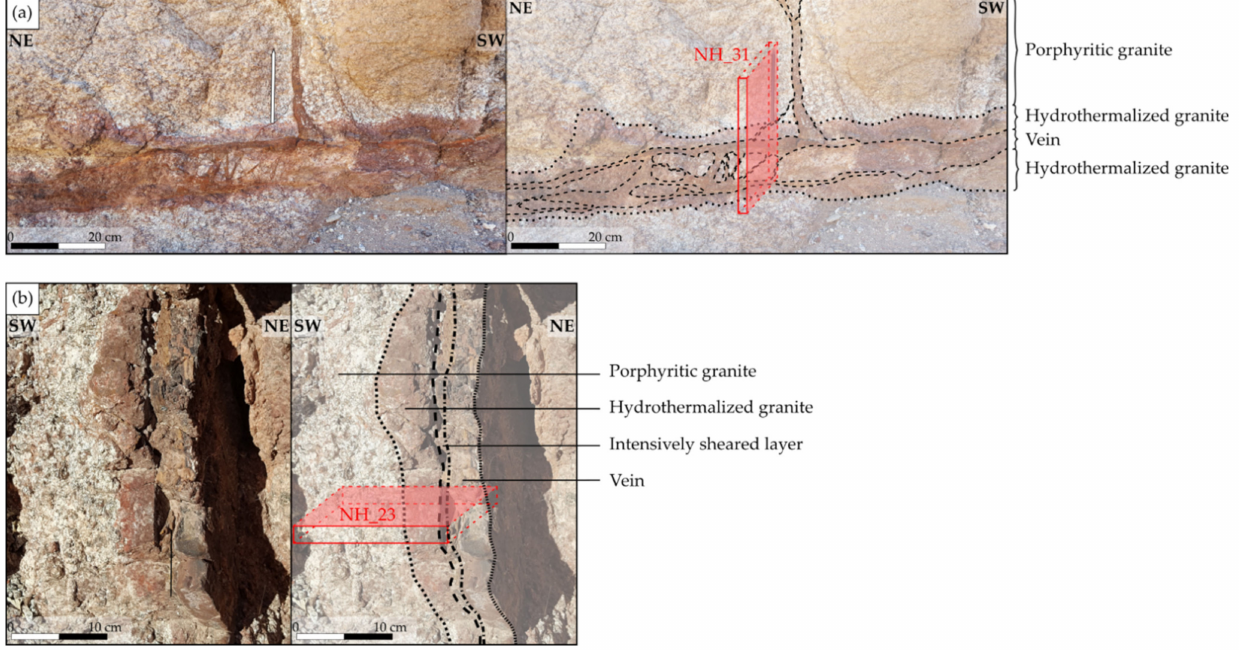
Figure 5. ( a ) Photograph and digitization of a brecciated and recrystallized vein also developing a gradient of alteration. Location of the sample NH_31 used as a case study in this section. ( b ) Photograph and digitization of a mylonitic vein developing a gradient of alteration. Location of the sample NH_23 used as a case study in this